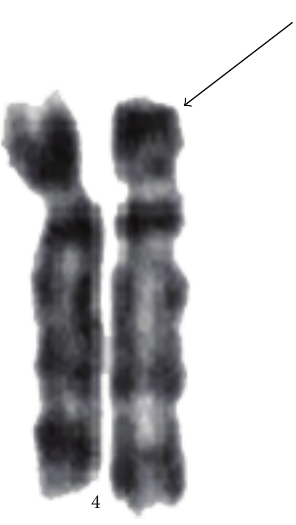
Figure 3: Arrow showing deletion at chromosome